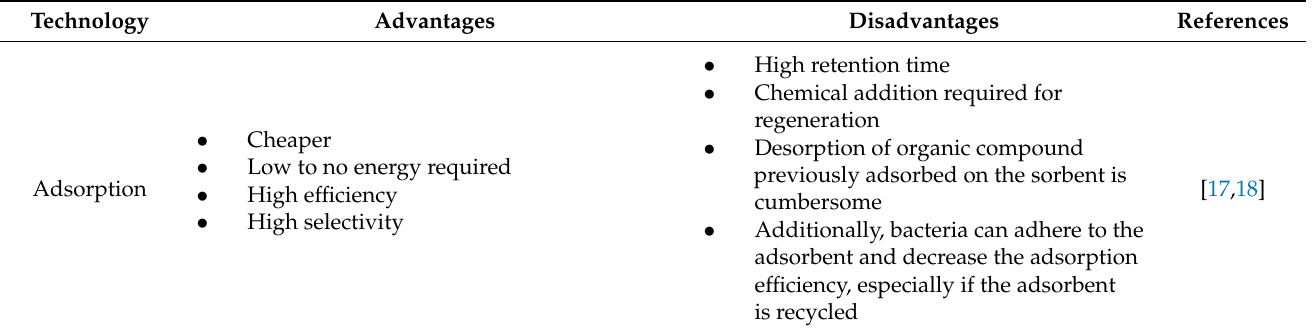
Table 1. Comparison of various solvent recovery